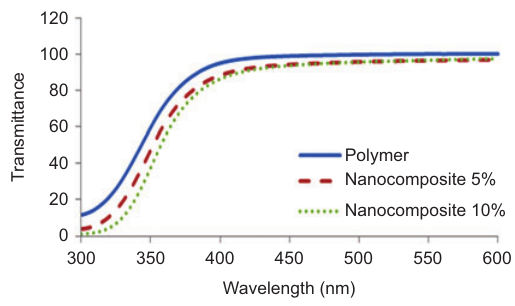
Figure 4 UV-visible spectra of PA 3 , and PA-nanocomposite fi lms 3a and 3b .